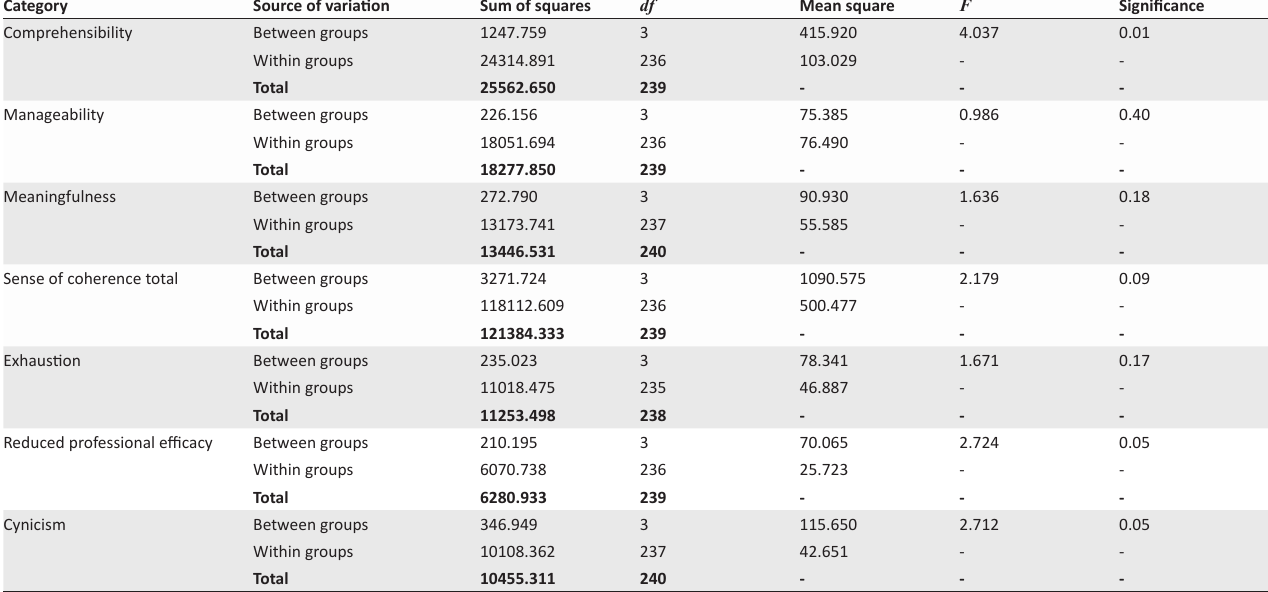
TABLE 3: Analysis of variance between age categories, sense of coherence and burnout. Category